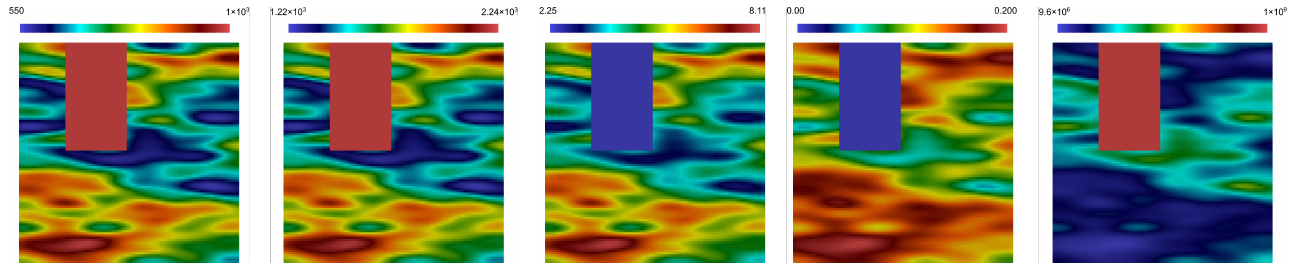
Figure 8. Distributions of c s , ρ s , k s , ¯ φ , and E s